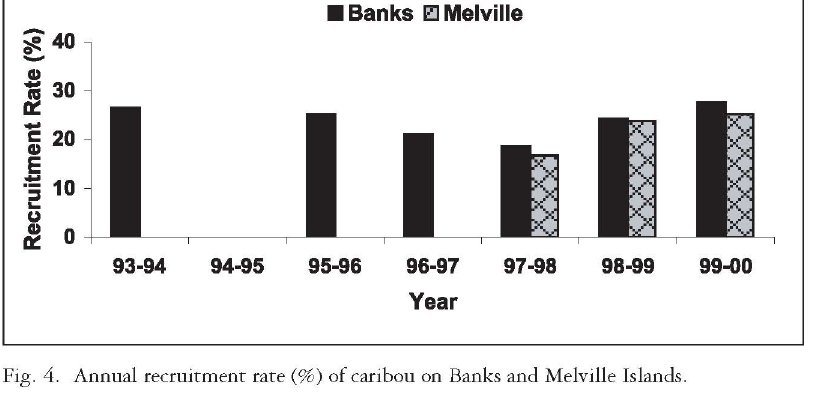
Fig. 4. Annual recruitment rate (%) of caribou on Banks and Melville Islands. as our data suggest. Since 1998, the recruitment rate for both populations has shown a positive